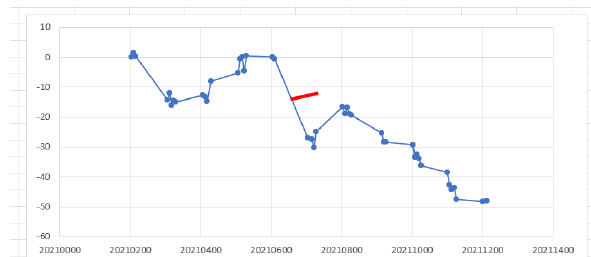
Figure 11. Surface displacement in mm, where there is the collapsed building, the redline indicates the date of collapsing.